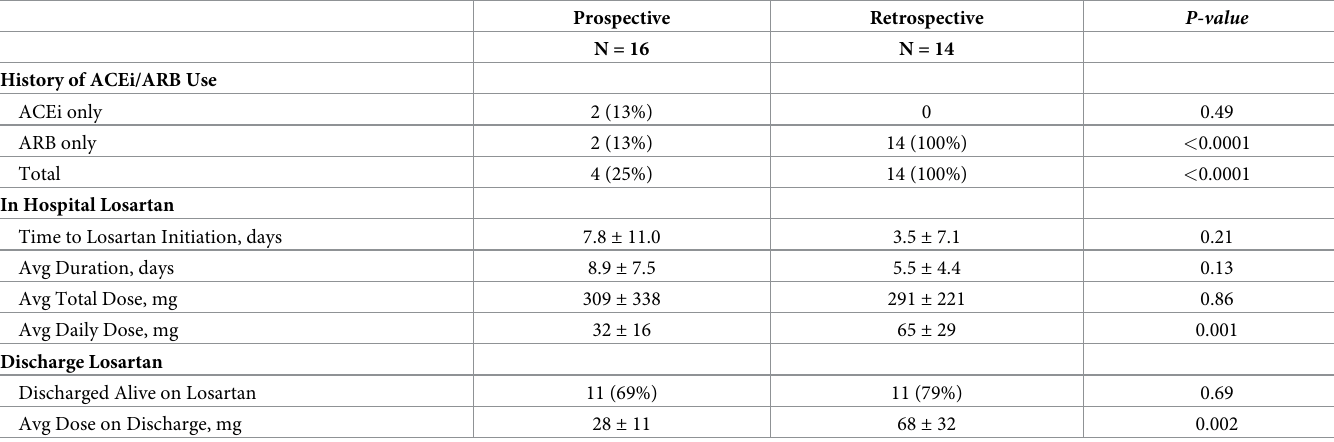
Table 2. Dosing of losartan in the study cohorts.